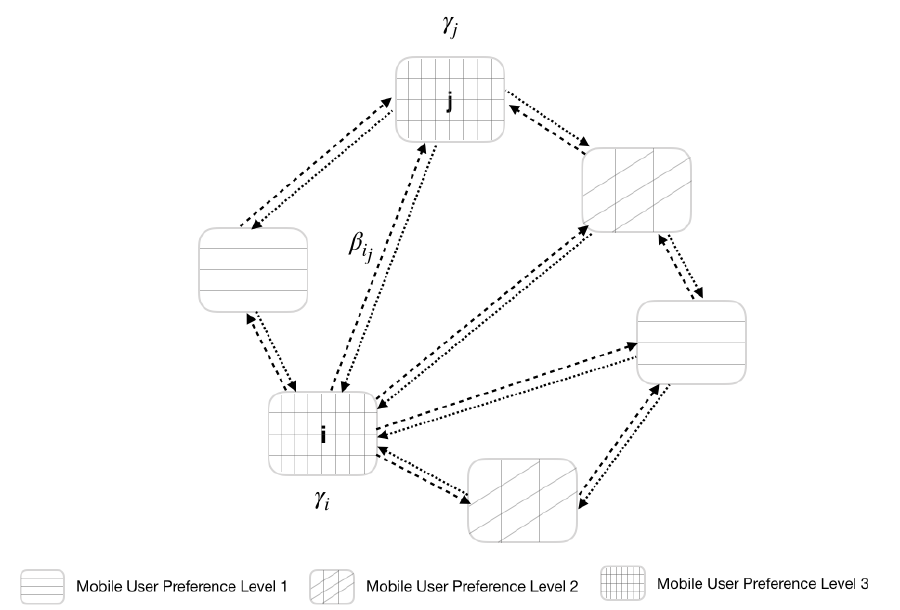
Figure 8. Mobility model used in the performance